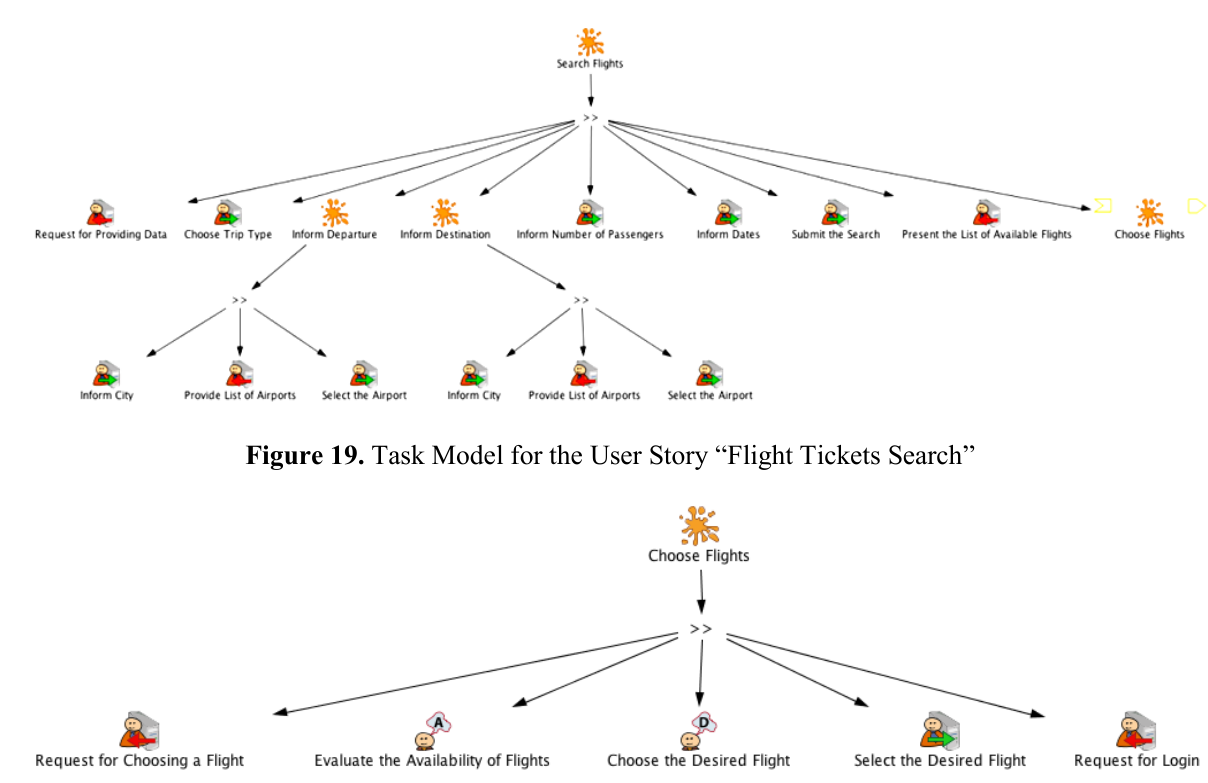
Figure 20. Task Model for the User Story “Select the desired flight” Table 3. The correlation between Requirements, Tasks and Scenarios in UCD and SE approaches for the User Story “Flight Tickets